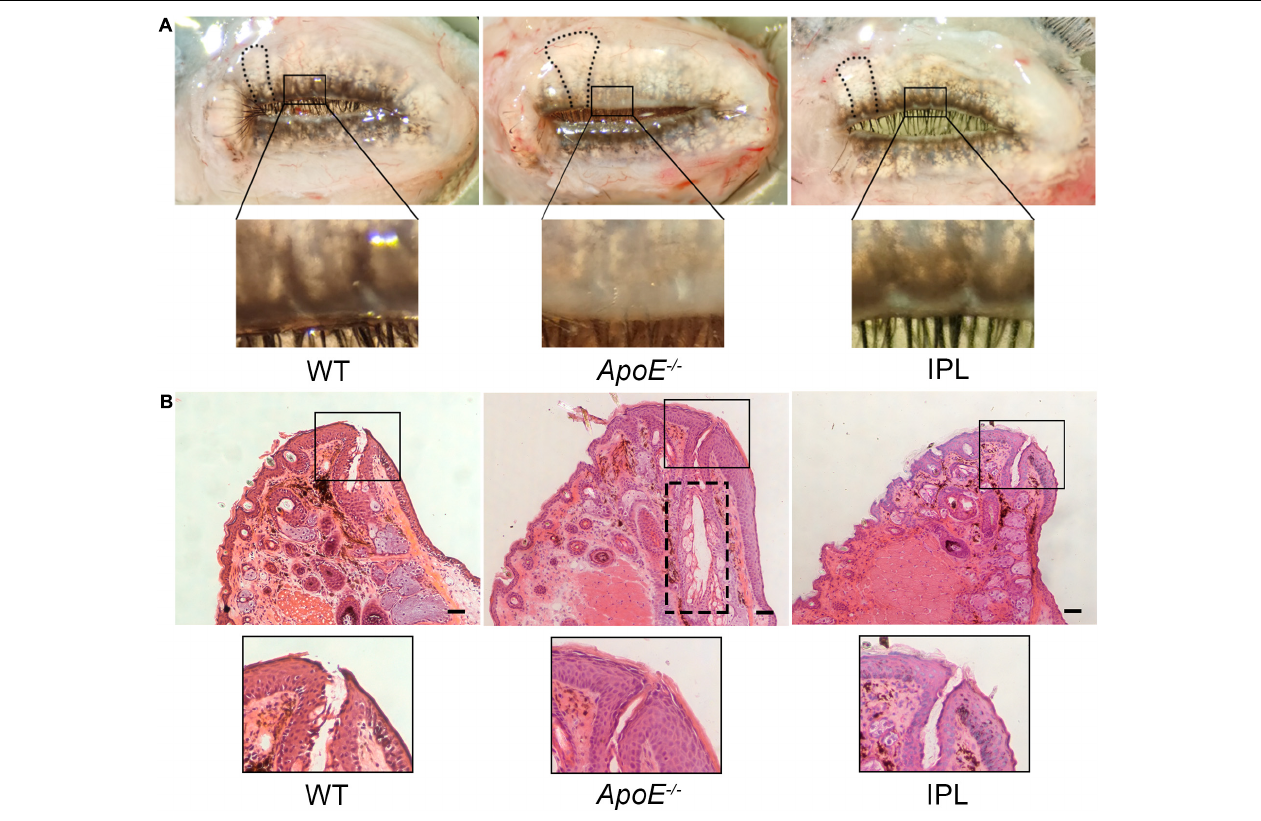
FIGURE 2 | Morphology and histology of MGs after IPL treatments. (A) Macrophotographs of MGs in eyelids. The black frame indicates unplugged orifices in WT mice and IPL-treated mice and plugged orifices in APOE − / − mice. The black line indicates that the morphological hypertrophy of MGs in IPL-treated mice was reduced. (B) H&E staining of the upper eyelids. The black frame indicates unplugged orifice in WT mice and IPL-treated mice and plugged orifice in APOE − / − mice. The black dotted line shows dilated central ducts. Scale bars: 50 µ